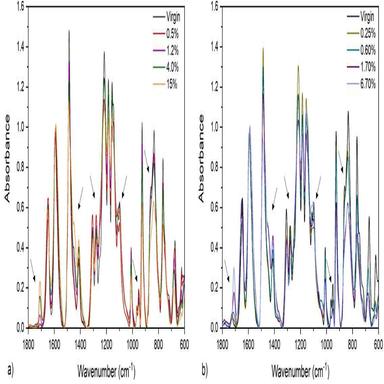
Spectral changes that occur at a) PEEK and b) CF-PEEK upon thermal degradation when heated with 50 ◦C/min up to a 0.5%, 1.2%, 4%, 15% and a 0.25%, 0.6%, 1.7%, 6.7% mass loss respectively (1800-600 cm-1).